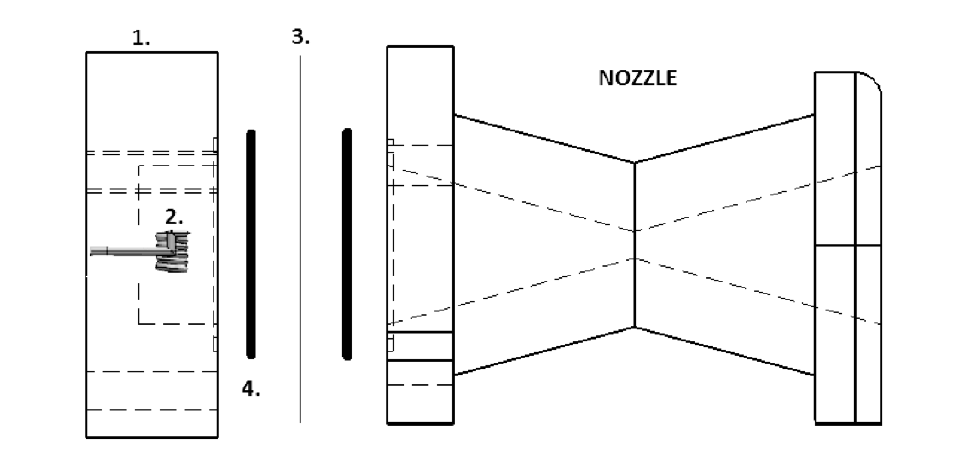
Figure 2. The basic thruster design consists of: (1) decomposition chamber; (2) heating element; (3) rupture disc; and (4) o-ring ( × 2). The converging/diverging nozzle has been outlined for